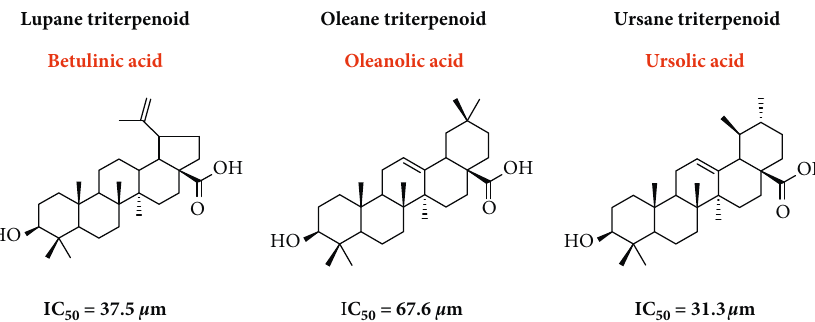
Figure 7: Antileukemic activities of different types of triterpenes isolated from SS leaves against K562 cell